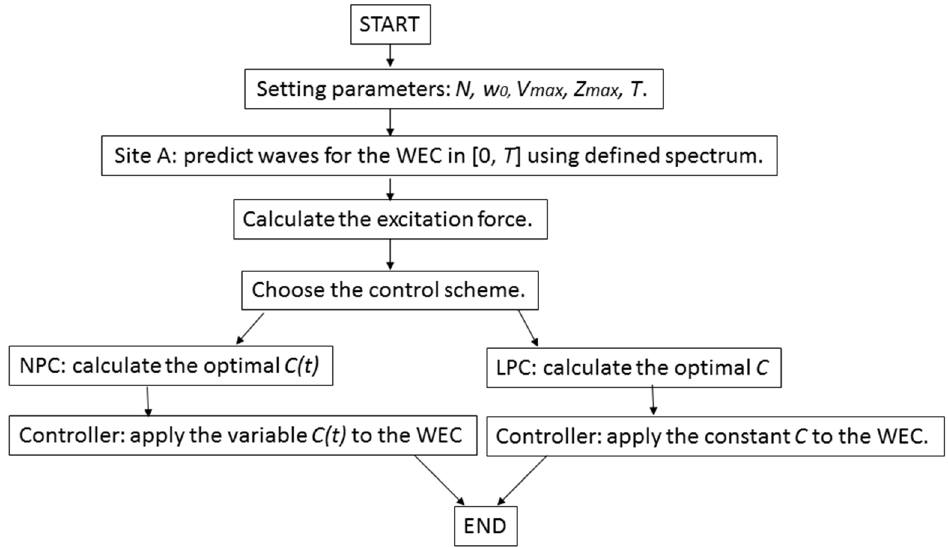
Figure 2. Control diagram for the